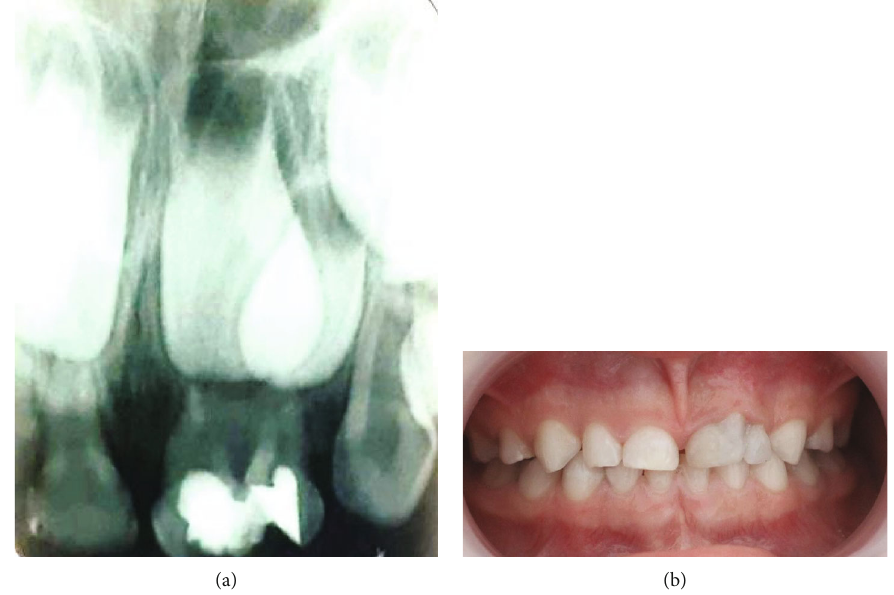
Figure 4: Treatment of teeth 61 and 62. Periapical radiograph showing pulpotomy (a). Coronal restoration